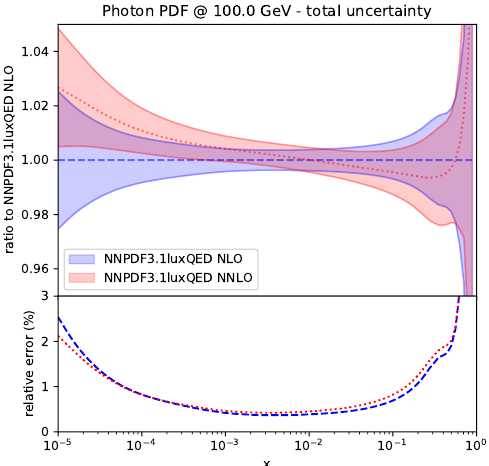
Figure 3.2: Comparison between γ ( x , Q ) in the NNPDF3.1luxQED NLO and NNLO fits.